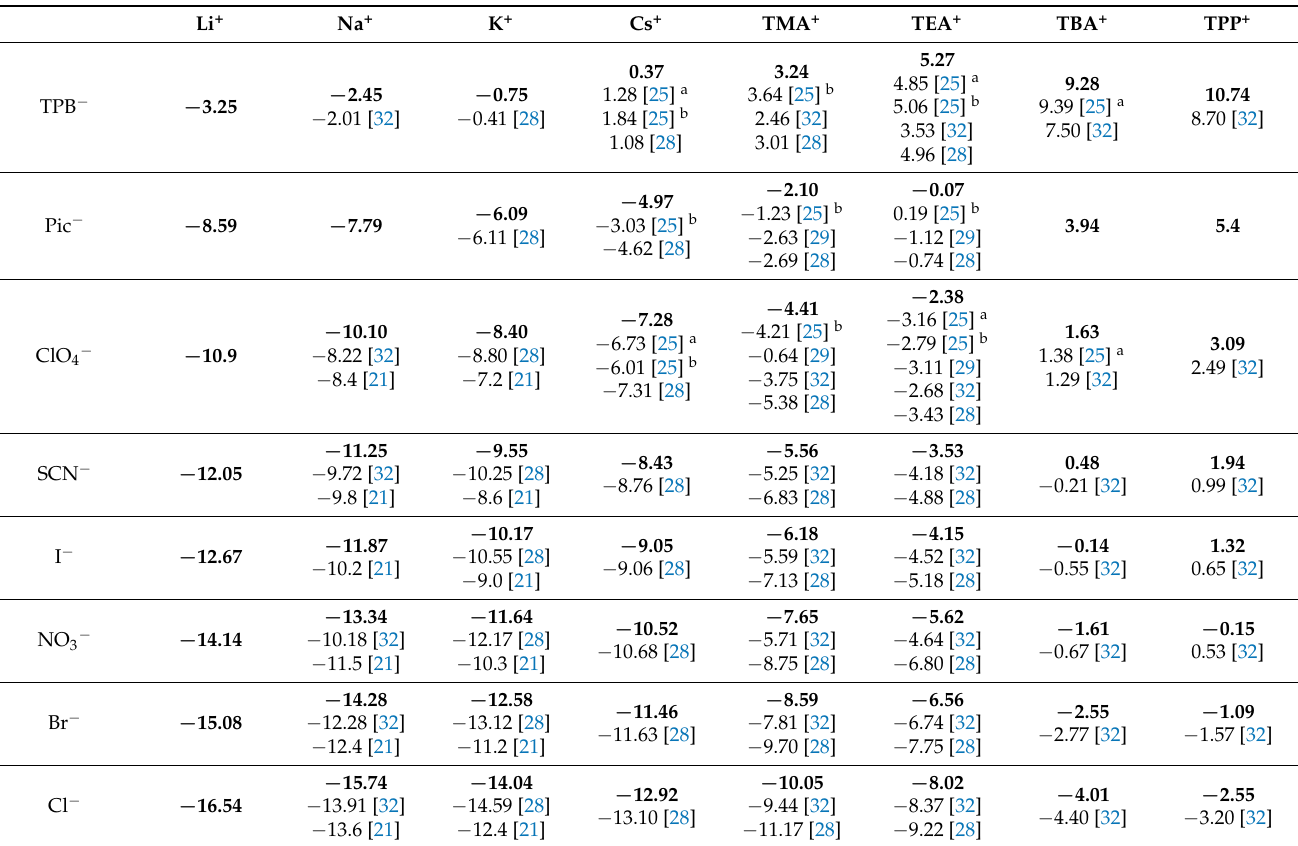
Table 3. Calculated coextraction constants for various electrolytes. Numbers in bold represent the results of the present